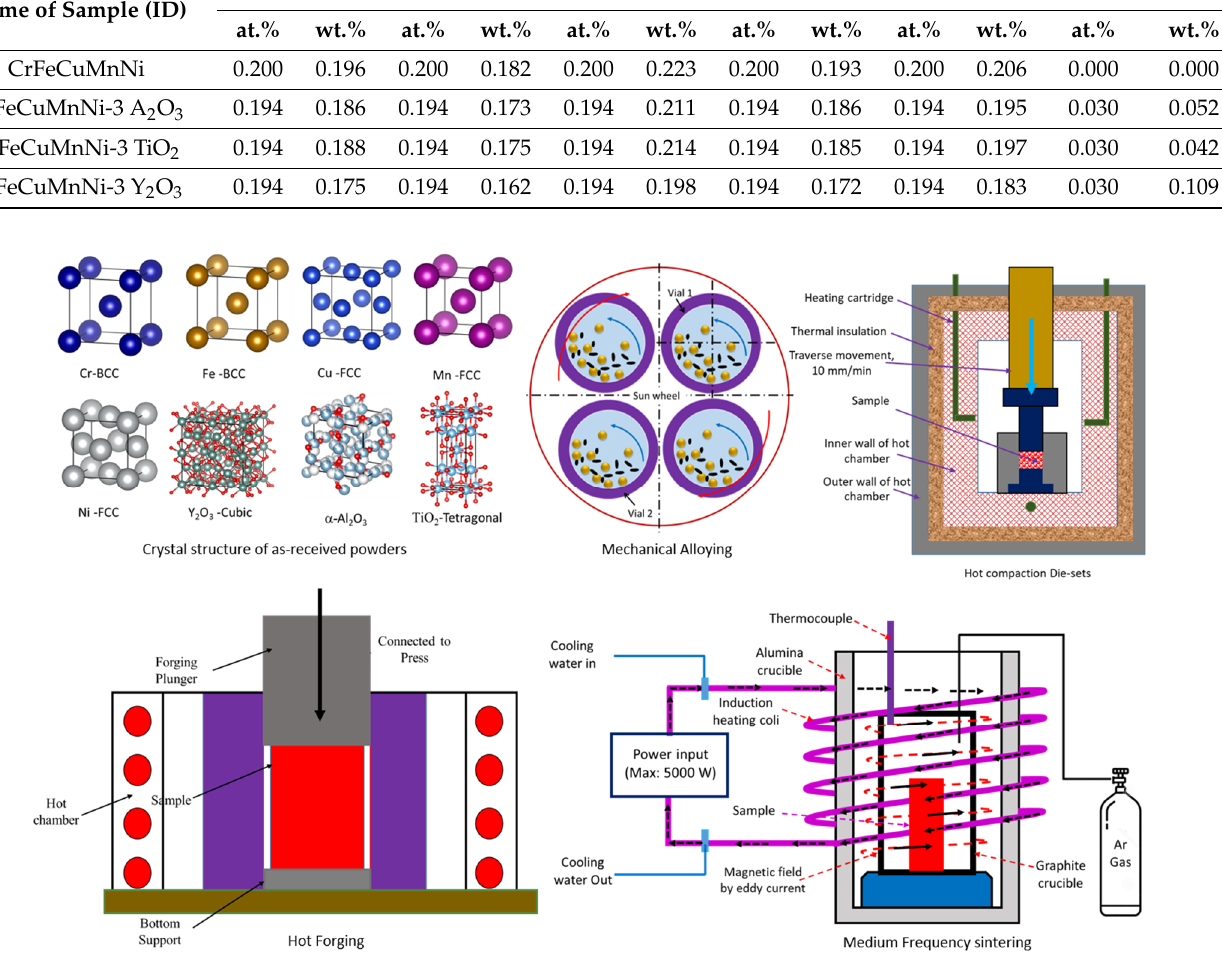
Figure 1. Schematic representing the development of oxide-dispersion-strengthened high-entropy composites (ODS-HECs) of CrFeCuMnNi-3 vol.% -Al 2 O 3 , CrFeCuMnNi-3 vol.% TiO 2 , and CrFeCuMnNi-3 vol.% Y 2 O 3 via MA followed by hot compaction, medium-frequency sintering, and hot forging .